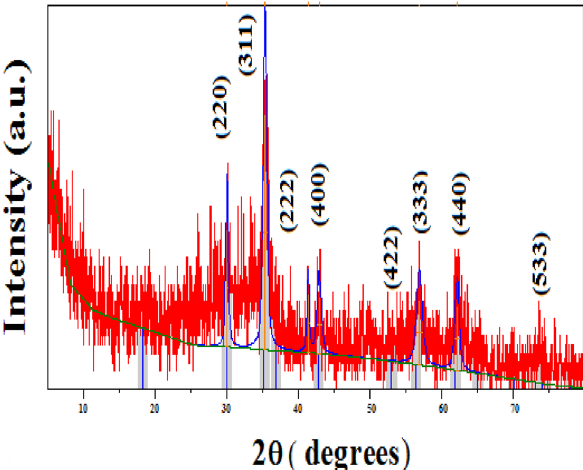
Figure 4. XRD pattern of manganese ferrite nanoparticle (MnFe 2 O 4 ).